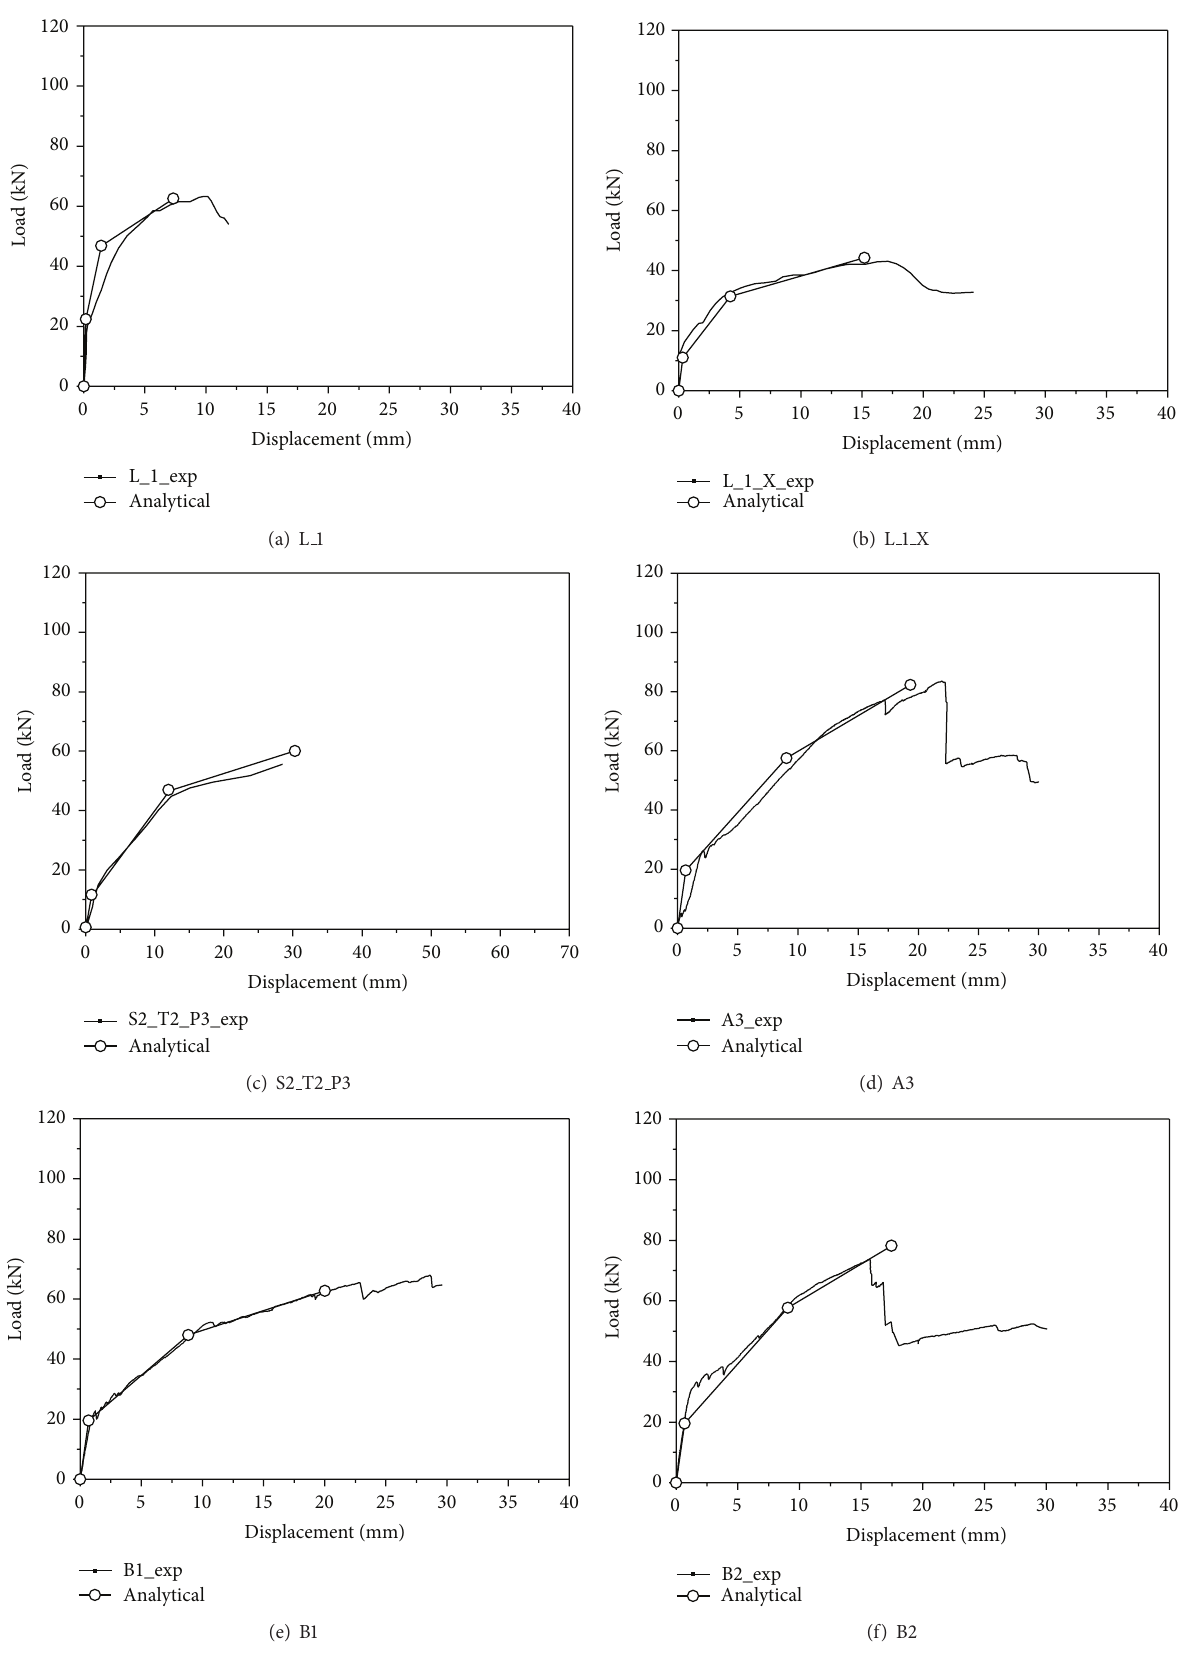
Figure 10: Comparisons of load-displacement